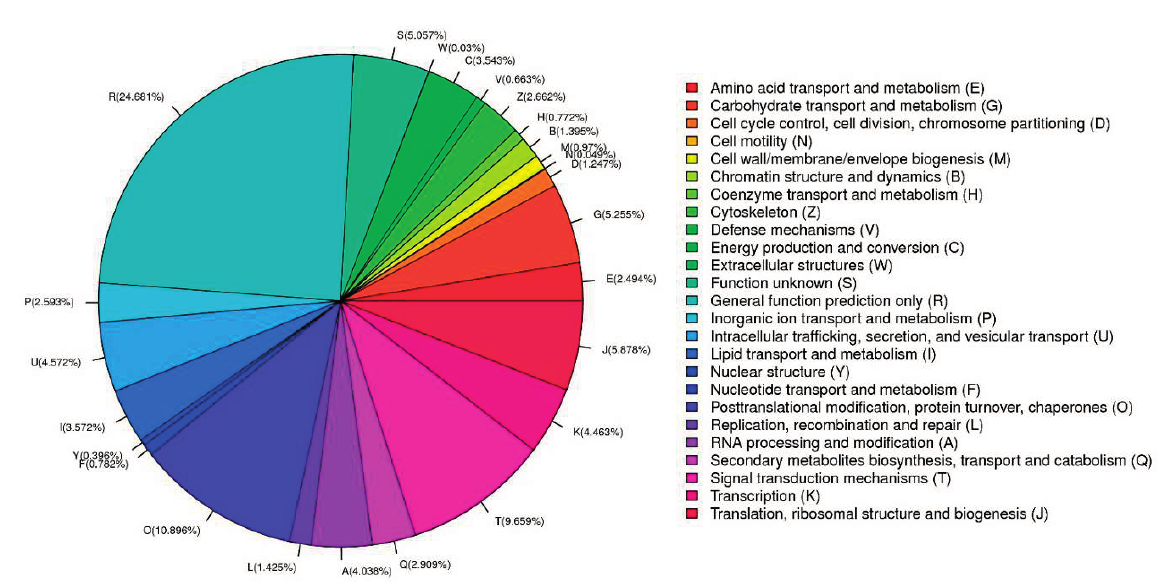
Figure 6. Clusters of orthologous groups (COG) classification. The safflower unigenes are classified into different functional groups based on the predicted proteins.